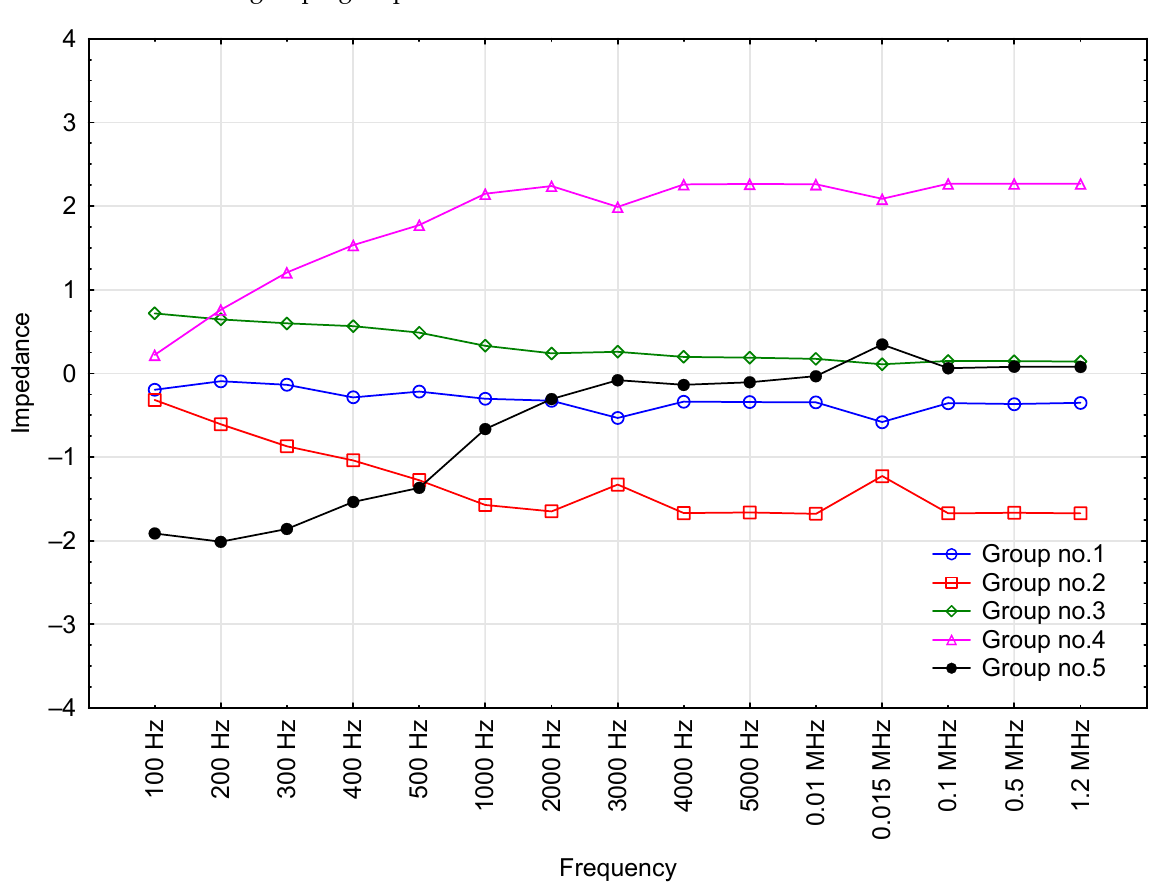
Figure 8. Effect of test voltage frequency on the average impedance magnitude of engine oils in each cluster (grouped by k-means).